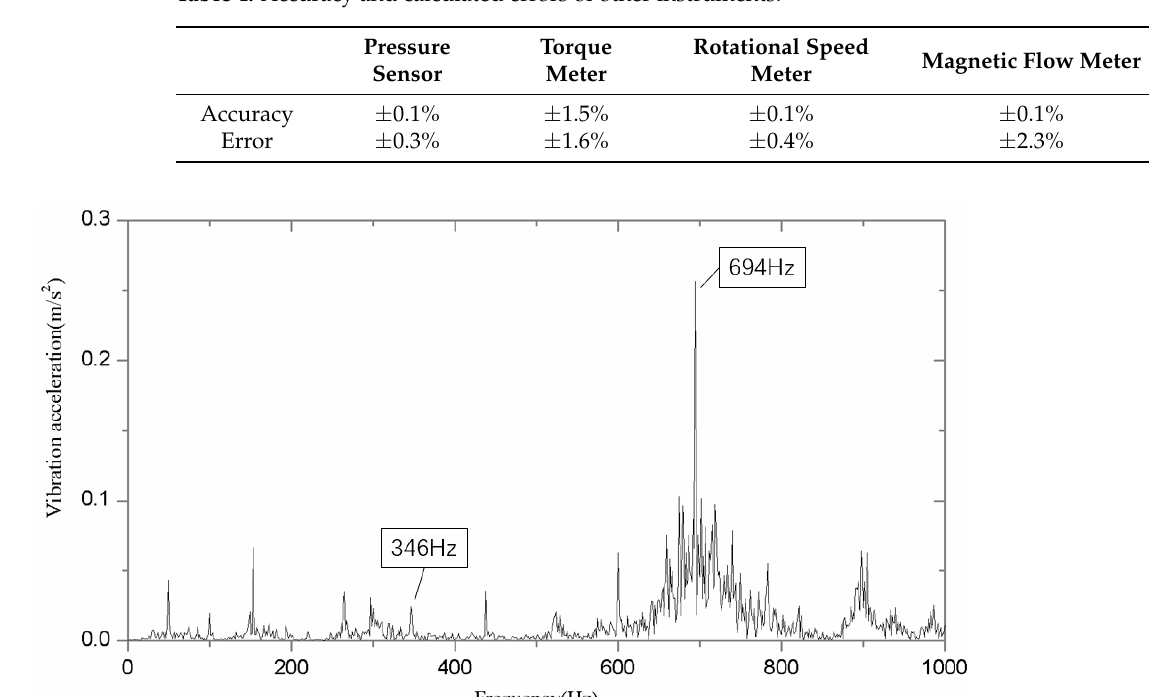
Figure 18. Vibration acceleration spectrum against frequency domain.